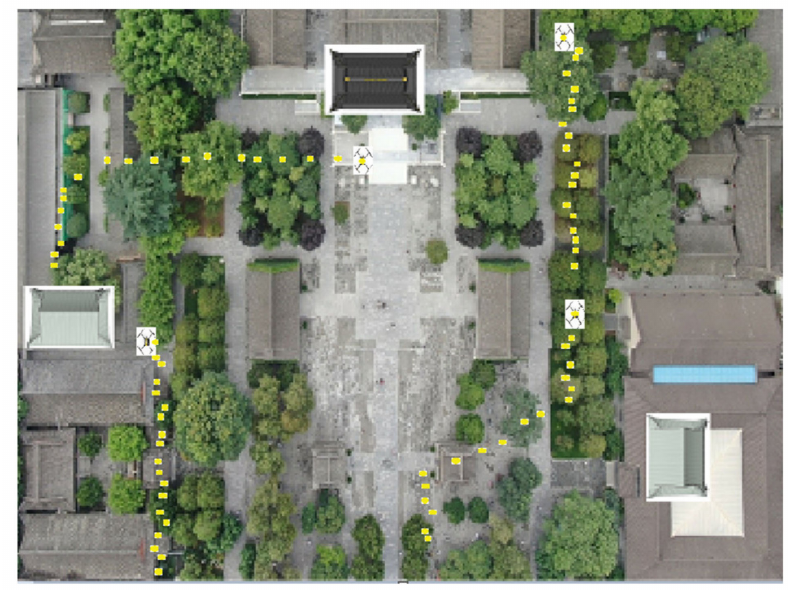
Figure 5. UAV trajectory (comprehensive